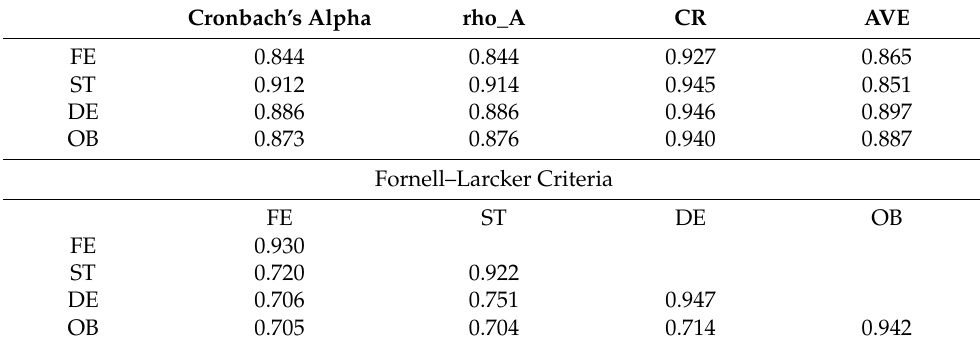
Table 5. Reliability and validity.